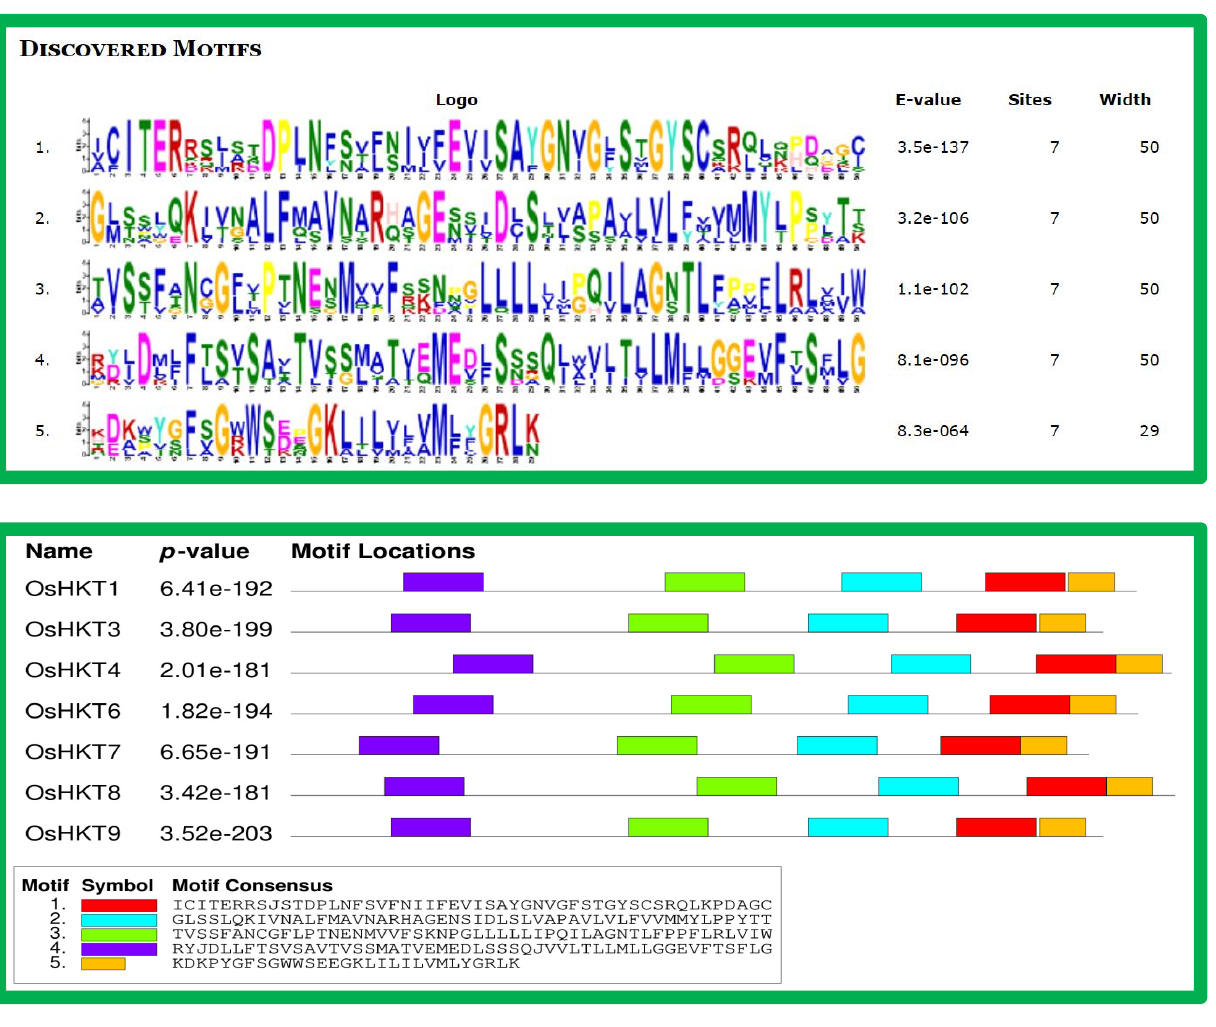
Figure 2. Conserved motifs analysis of OsHKT genes in rice. The motif locations and logo are pre- sented separately. The sequences of 5 conserved motifs are presented in the box called Motif Con- sensus.